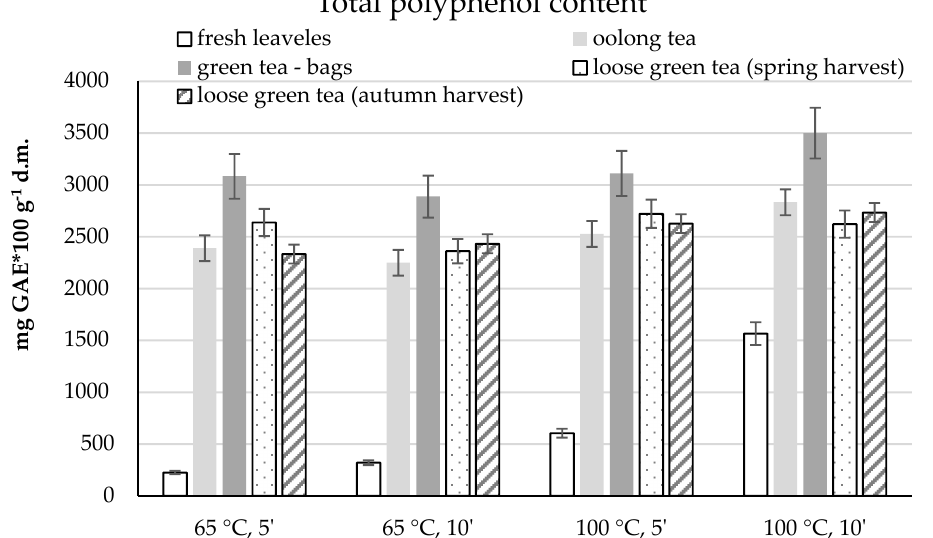
Figure 4. The content of total polyphenols in water infusions of tea shrub leaves and various types of teas, depending on the brewing parameters.